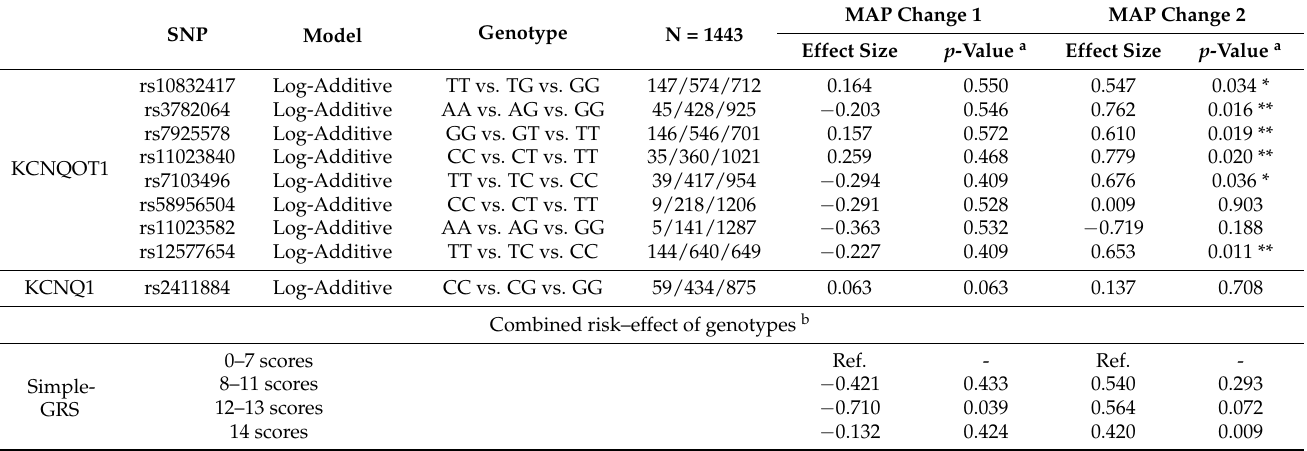
Table 2. Genotype and allele frequencies of lncRNA SNPs, and genotype risks in the second